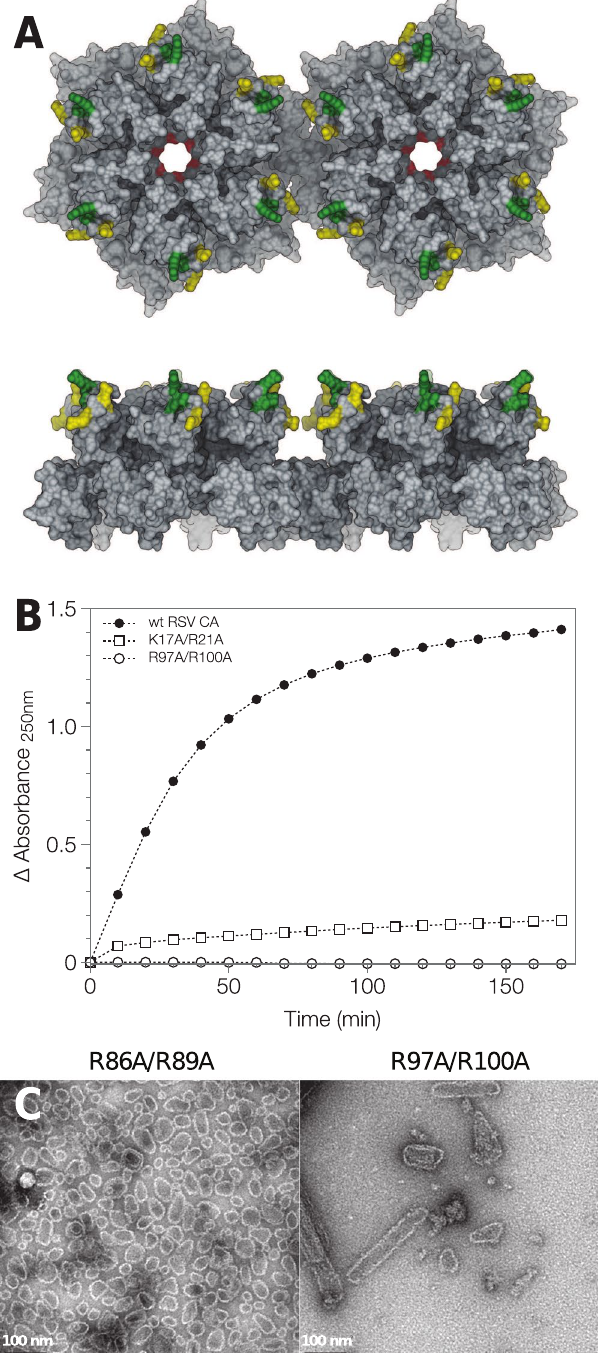
Figure 5. Effect of charge neutralizing mutations on RSV CA tube assembly. ( A ) The location of the charge neutralizing mutations introduced into RSV CA. Two RSV CA hexamers from a planar array (PDB ID: 3TIR) are shown in molecular surface representation, viewed from both the top and the side. Surface coloration indicates the location of mutations K17A/R21A (red), R86A/R89A (yellow) and R97A/R100A (green). ( B ) The mutations repress or abrogate tube assembly under physiological conditions. Wild type RSV CA and charge neutralized variants K17A/R21A and R97A/R100A (all 300 μ M) were incubated in 12.5 mM MOPS/KOH pH 7.0, 75 mM NaCl, 10%(w/v) Ficoll 400 at 34 °C. Assembly was monitored using apparent absorbance at 250 nm. The displayed data are the mean of duplicate experiments. ( C ) The variants retain the ability to assemble into core-like-particles under non-physiological conditions. TEM images of typical assembly products are shown, following negative staining with uranyl acetate. To promote assembly, mutants R86A/R89A and R97A/R100A were dialyzed against neutral pH storage buffer at 37 °C, containing either 1.5 M NaCl (R86A/R89A) or 0.8 M NaCl (R97A/R100A). The program UCSF chimera 110 was used to generate parts of this figure, as well as Figs 8 and